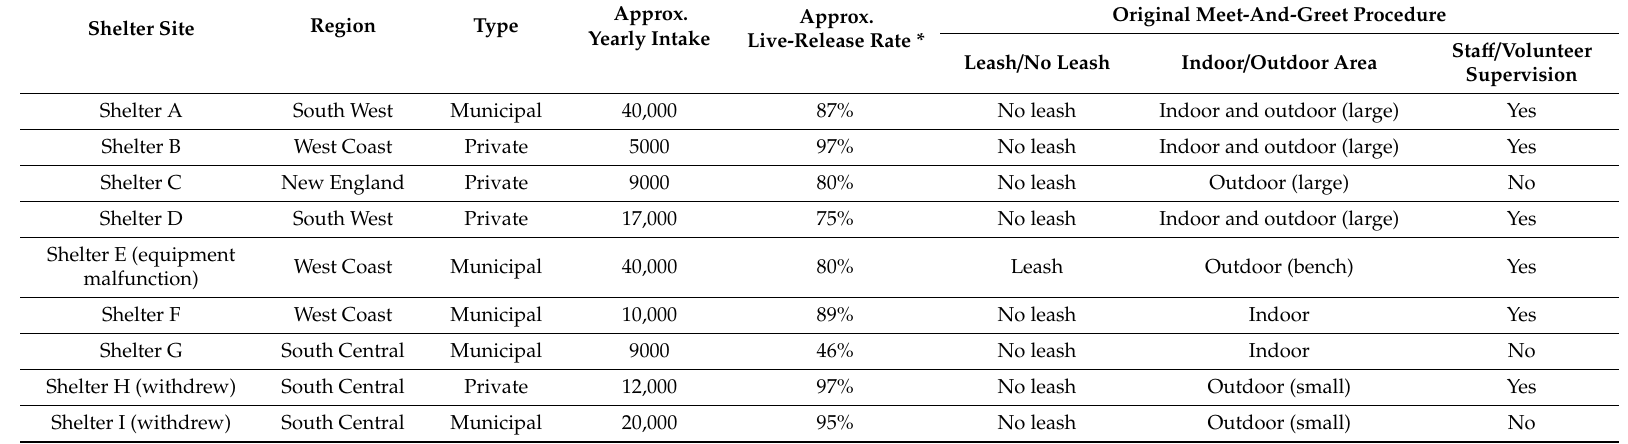
Table 2. Characteristics of participating animal shelters at the time of the